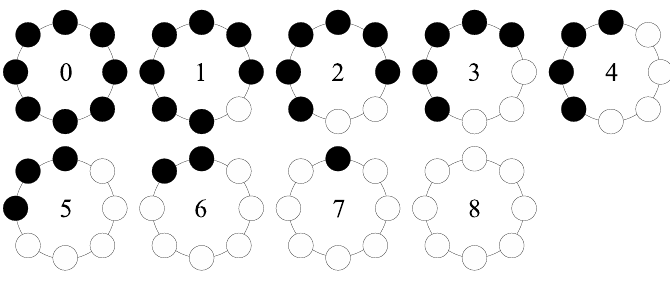
Figure 2. Nine uniform patterns of LBP riu 2